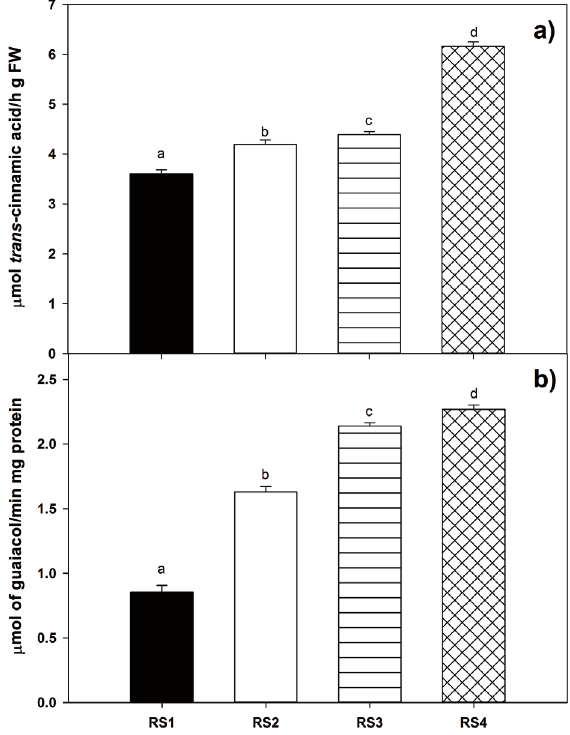
Fig. 7: Enzyme activity of phenylalanine ammonia lyase, PAL (a) and per- oxidase, POD (b) from pineapple cv. Esmeralda at four ripening sta- ges (RS). Different letters indicate significant differences (p < 0.05), n